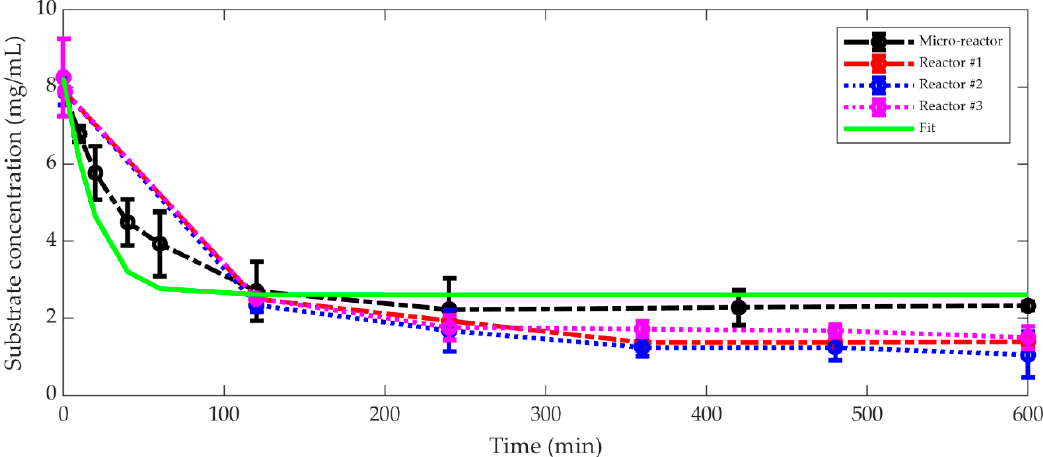
Figure 4. Comparison between micro-reaction and bench scale reactor trajectory assayed with the same operational parameters (pH 4.64; T 52 °C; enzyme–substrate ratio = 1.8 mL enzyme/g cellulose).